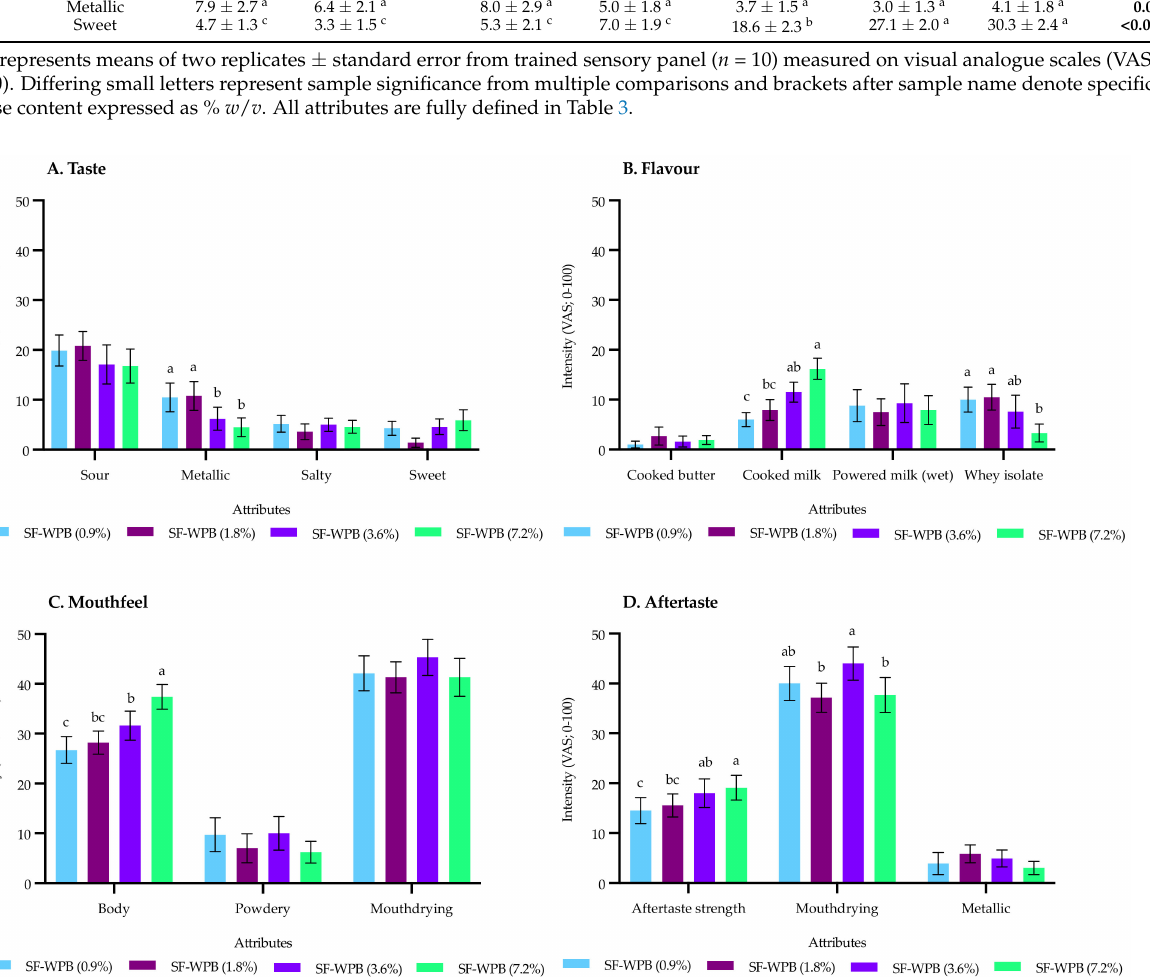
Figure 2. Influence of fat content on the sensory profile of whey protein liquid models (SF-WPB: sugar-free whey protein beverage). Data represents means of two replicates ± standard error from trained sensory panel ( n = 11) measured on visual analogue scales (VAS; 0–100). Differing small letters represent sample significance from multiple comparisons and brackets after sample name denote specific fat content expressed as % w / v . All attributes are fully defined in Table